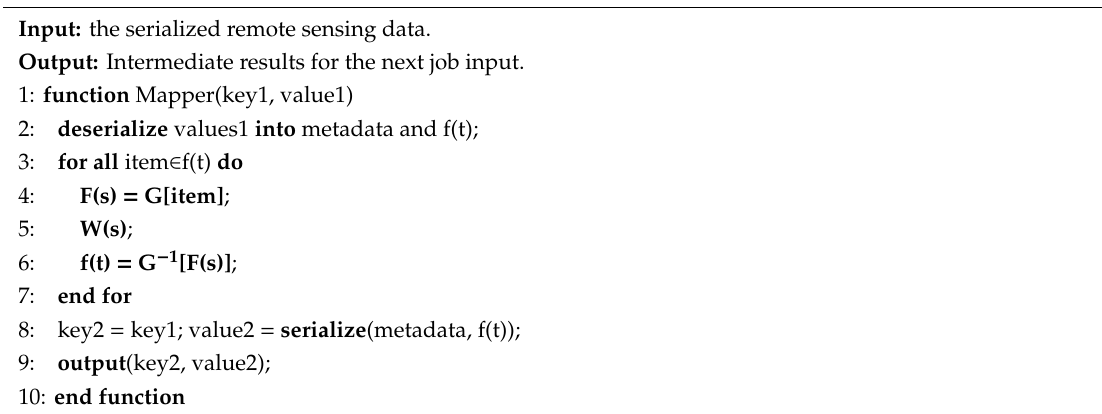
Algorithm 5: The cloud computing model for Frequency Domain